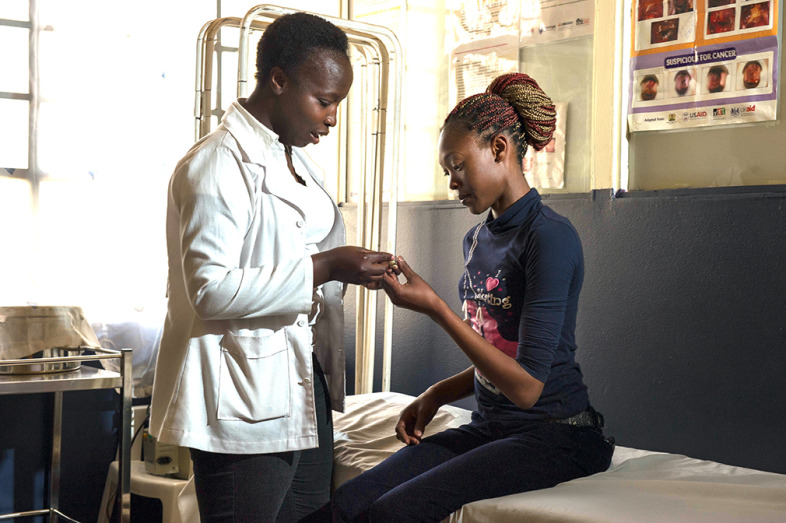
Liz Brenda Kandeyi, nurse (left), takes a client through the steps for clinical services at Kikuyu Sasa Center, Nairobi, Kenya. © 2017 Nancy Coste/FHI 360